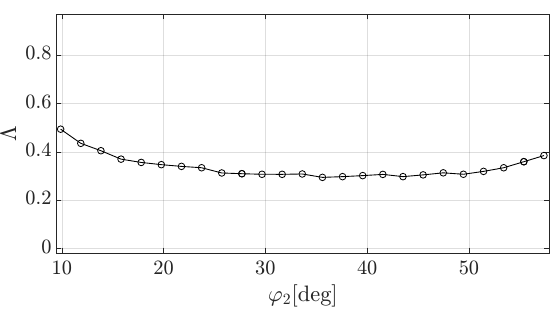
Figure 6. Lambda factor ( Λ ) over a mesh